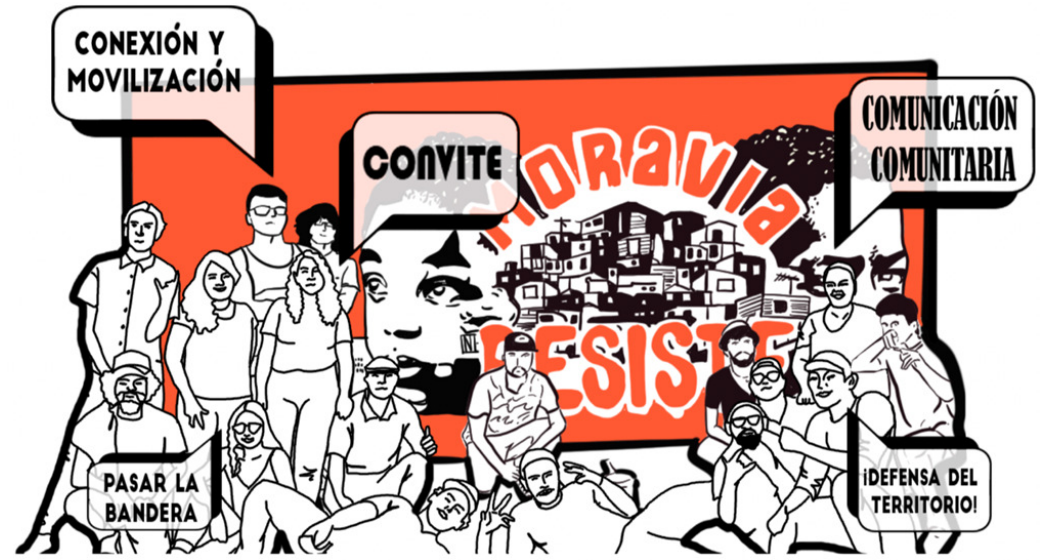
Figure 3. Moravia Resiste Collective. Source: Drawn by Community Connections Team cohort 2020–2021 for Atlas of Living